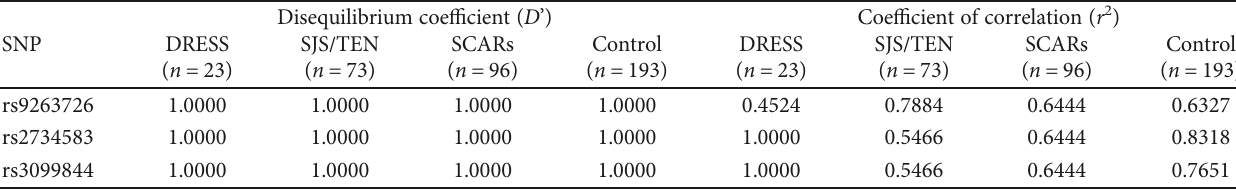
Table 4: Concordance between selected SNPs and HLA-B ∗ 58: 01 allele in allopurinol-induced SCARs. Disequilibrium coe ffi cient ( D ’ ) Coe ffi cient of correlation ( r 2 SNP